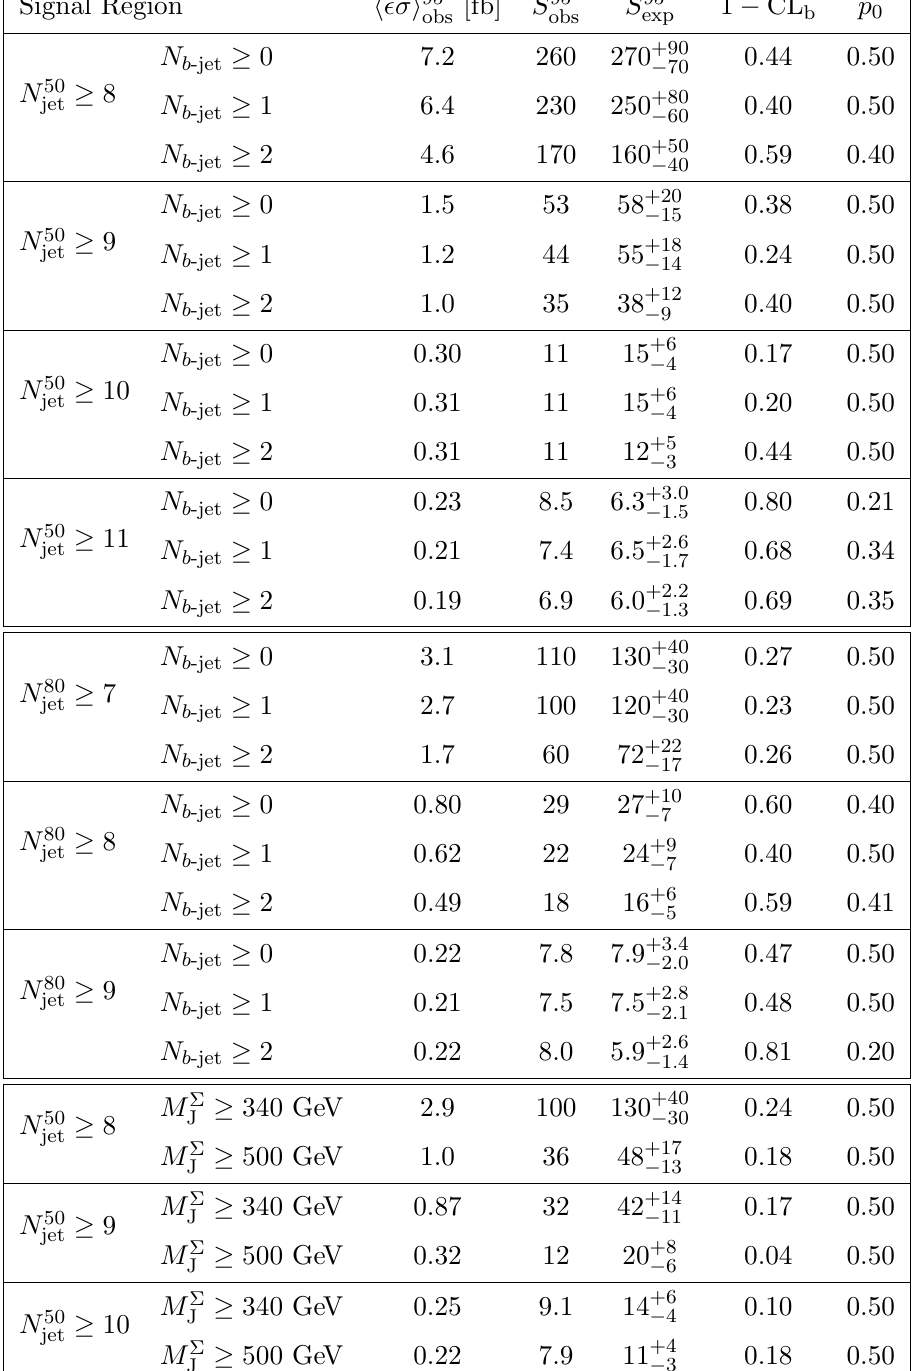
Table 5. Left to right: 95% CL upper limits on the visible cross-section ( h (cid:15)(cid:27) i 95 ) and on the obs number of signal events ( S 95 ). The third column ( S 95 ) shows the 95% CL upper limit on the exp obs number of signal events, given the expected number (and (cid:6) 1 (cid:27) excursions on the expectation) of background events. The last two columns indicate 1 (cid:0) CL b , i.e. the complement of the p -value observed for the background-only hypothesis, and the discovery p -value ( p 0 ).